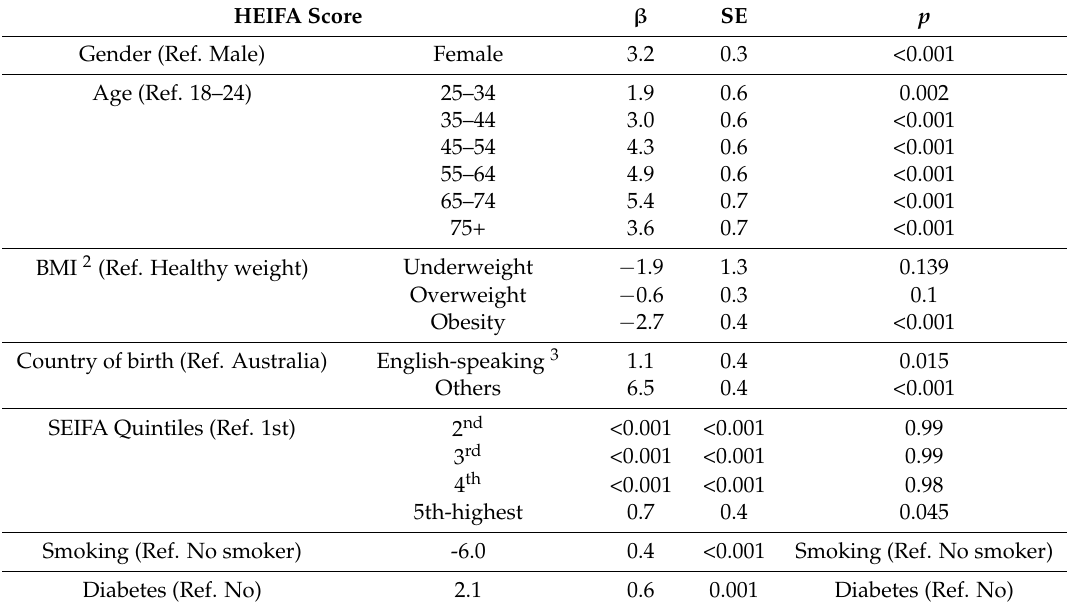
Table 3. Association of HEIFA-2013 score with socio-demographic covariates. HEIFA Score β SE p Gender (Ref. Male)